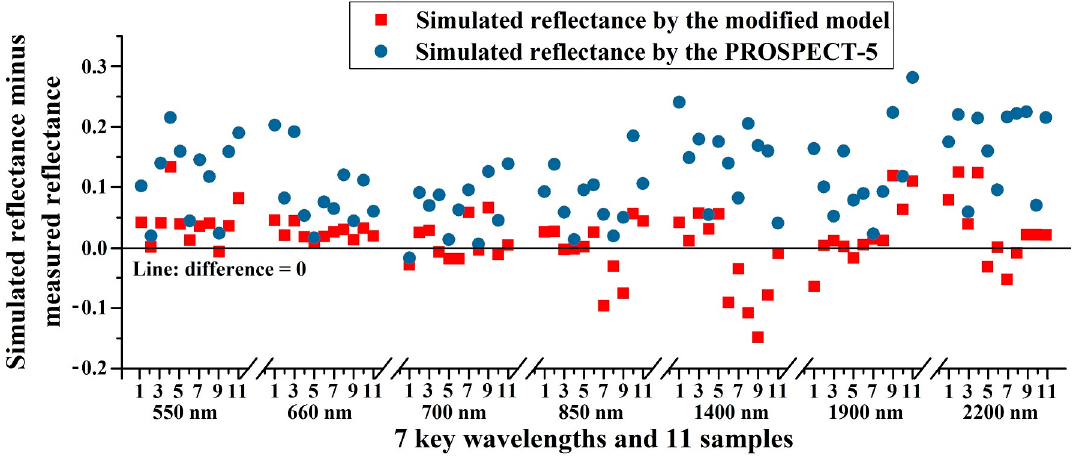
Figure 8. Differences between simulated reflectance and measured reflectance at key wavelengths. Table 3. Root mean square errors (RMSEs) between the simulated spectra (PROSPECT-5 and the new model) and measured spectra of 11 groups samples used for validation.